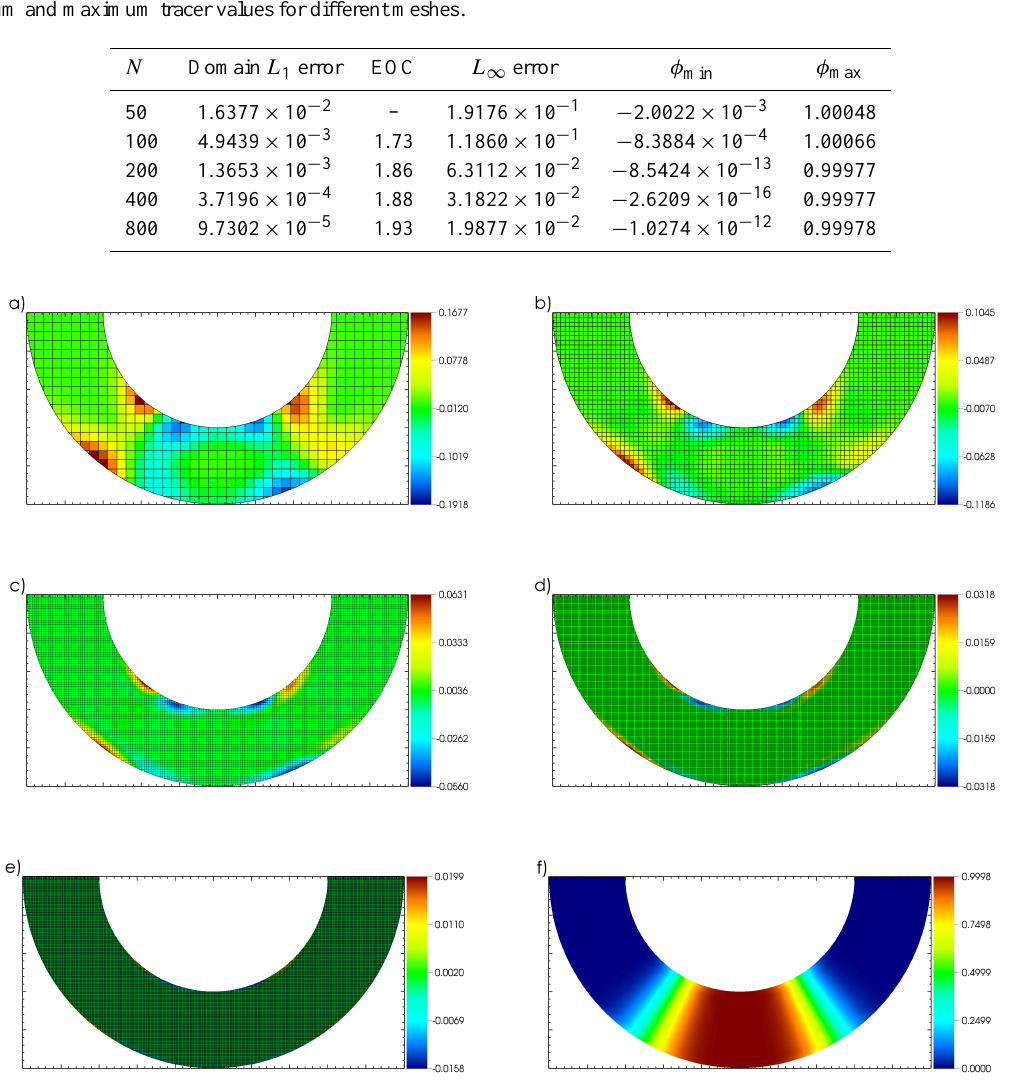
Figure 14. Computational meshes and difference scalar fields of φ for (a) N = 50, (b) N = 100, (c) N = 200, (d) N = 400, (e) N = 800, and (f) the scalar field for N = 400 after one rotation.